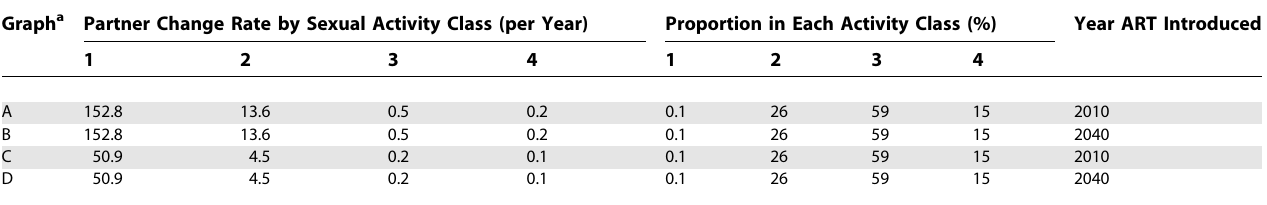
Other parameters: All other parameters as in Table 1 using best-case scenario values with unlimited treatment coverage. a GraphsA–DrefertothosedescribedinFigures2and3:A,high-prevalence,matureepidemicwithARTintroducedin2010beforeepidemicequilibrium;B,high-prevalence,matureepidemicwithARTintroducedin2040 once epidemic equilibrium is reached; C, smaller-scale epidemic with ART introduced in 2010 early in the epidemic; D, smaller-scale epidemic with ART introduced in 2040 after the peak of the epidemic. DOI: 10.1371/journal.pmed.0030124.t002 PLoS Medicine |